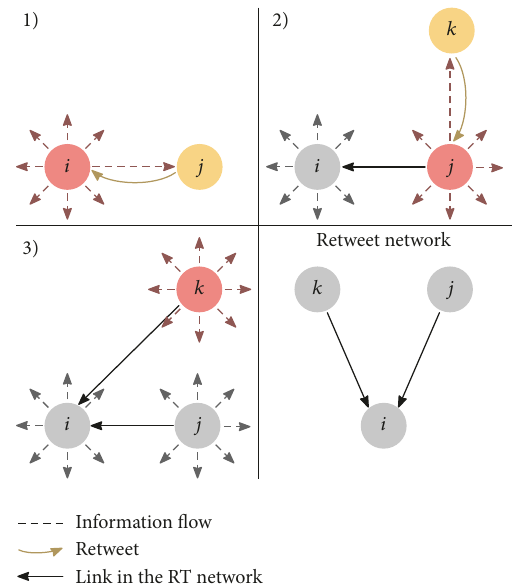
Figure 1: Schemethat shows the method used to build the networks ofretweets.Inpanel1),user 𝑖 postsamessagestartinganinformation flow that reaches user 𝑗 , who decides to retweet it. In panel 2), the message retweeted by 𝑗 is read by 𝑘 who in turn retweets it again. In panel 3) the three users are information transmitters and in the last panel the resulting retweet network is